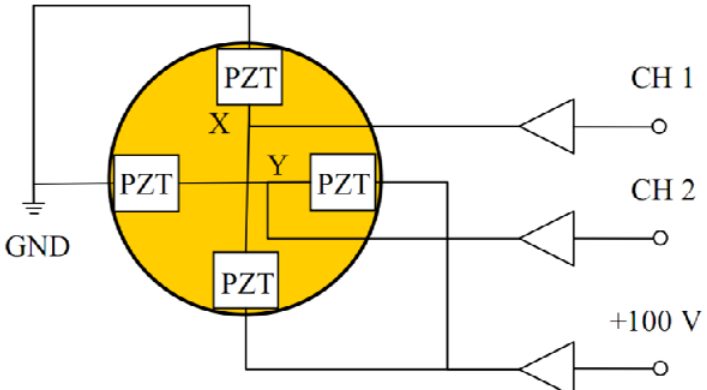
Figure 4. Working principle of the piezo-based platform in both X-axis and